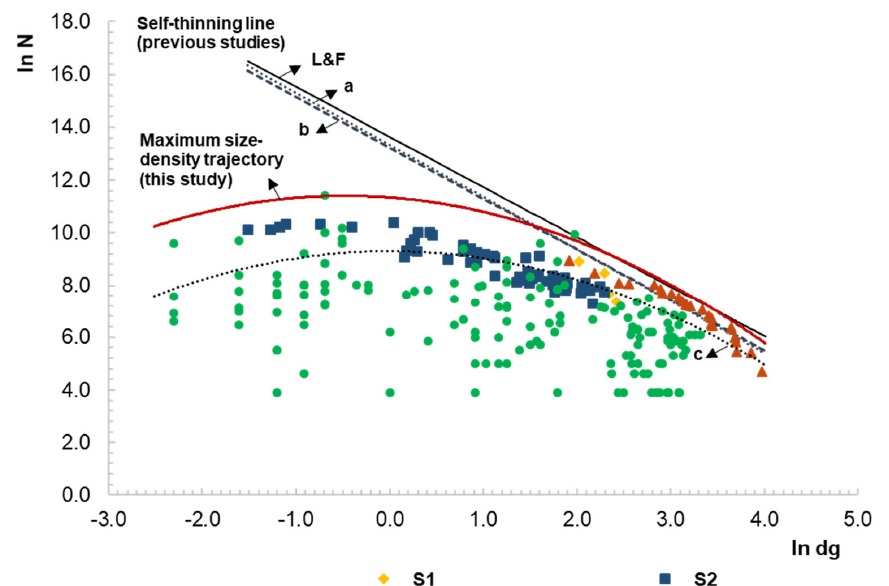
Figure 5. Size–density trajectories for maritime pine as defined in previous research (L&F—Luis and and Fonseca [28]; a —Aguirre et al. [21]; b —R í ofrio et al. [30]; c —Charru et al. [26]) and in the current Fonseca [28]; a —Aguirre et al. [21]; b —Ríofrio et al. [30]; c —Charru et al. [26]) and in the current study—line in red. The points represented in the graph refer to the four data study—line in red. The points represented in the graph refer to the four data subsets.